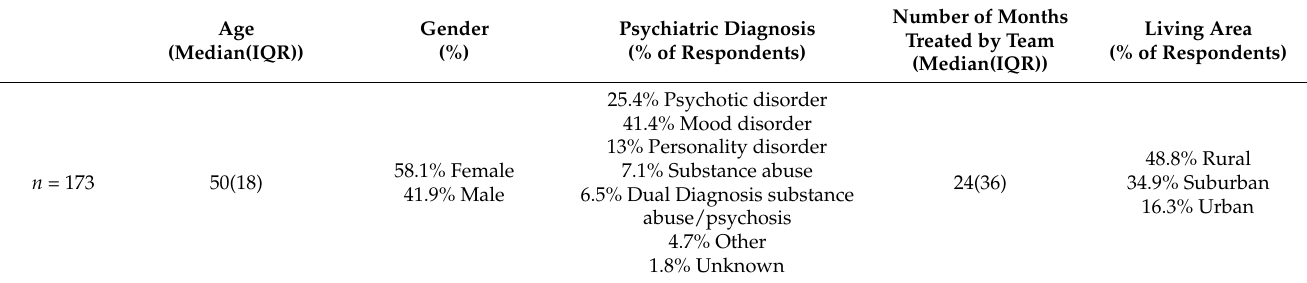
Table 1. Demographic data of respondents included in the